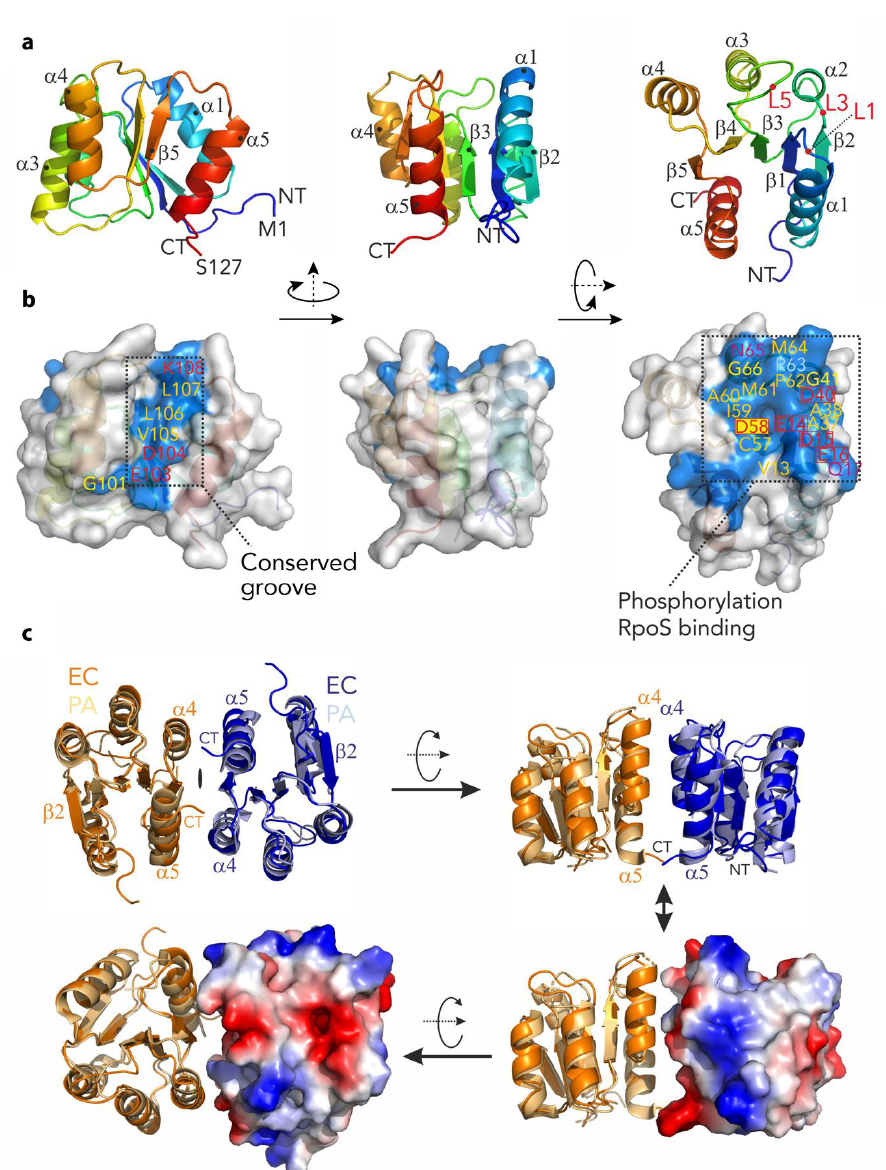
Figure 4. The structure of the N-terminal domain of RssB (RssB N ) and putative dimer. ( a ) Structure of the N-terminal domain shown in cartoon representation and color coded from the N- (NT; Met1; in blue) to the C-terminus (CT; Ser127; in red) using rainbow colors. The structure is shown from three di ff erent angles which are related by rotation of 90 degrees around the y -axis and second rotation of 90 degrees around x -axis. The five-stranded β -sheet ( β 1– β 5) is surrounded by α -helices ( α 1– α 5). ( b ) Structure of RssB N in the same orientation as in ( a ) as surface representation with conserved residues colored in blue and named according to the sequence. Hydrophobic residues are marked in orange, glycine residues are marked in yellow, hydrophilic residues are marked in magenta and charged residues are marked in red. The conserved phosphorylation site on Asp58 is marked with a yellow rectangle. There are two conserved patches visible on the surface. The conserved groove on the left represents a putative dimerization interface, while the extended and conserved surface on the right is indicative for interactions with the substrate protein σ s after phosphorylation. This patch is particularly negatively charged with a high density of acidic residues. ( c ) Comparison of the N-terminal domain structures of RssB from E. coli (EC—in dark orange and dark blue) and P. aeruginosa (PA—in light orange and light blue). Three di ff erent perspectives are shown. The structures are virtually identical for the β –sheet and adjacent α –helices but varies in loop structures (superimposed with a r.m.s.d. of 1.3 Å). In the lower images the electrostatic surface of one of the subunits from the E. coli protein is